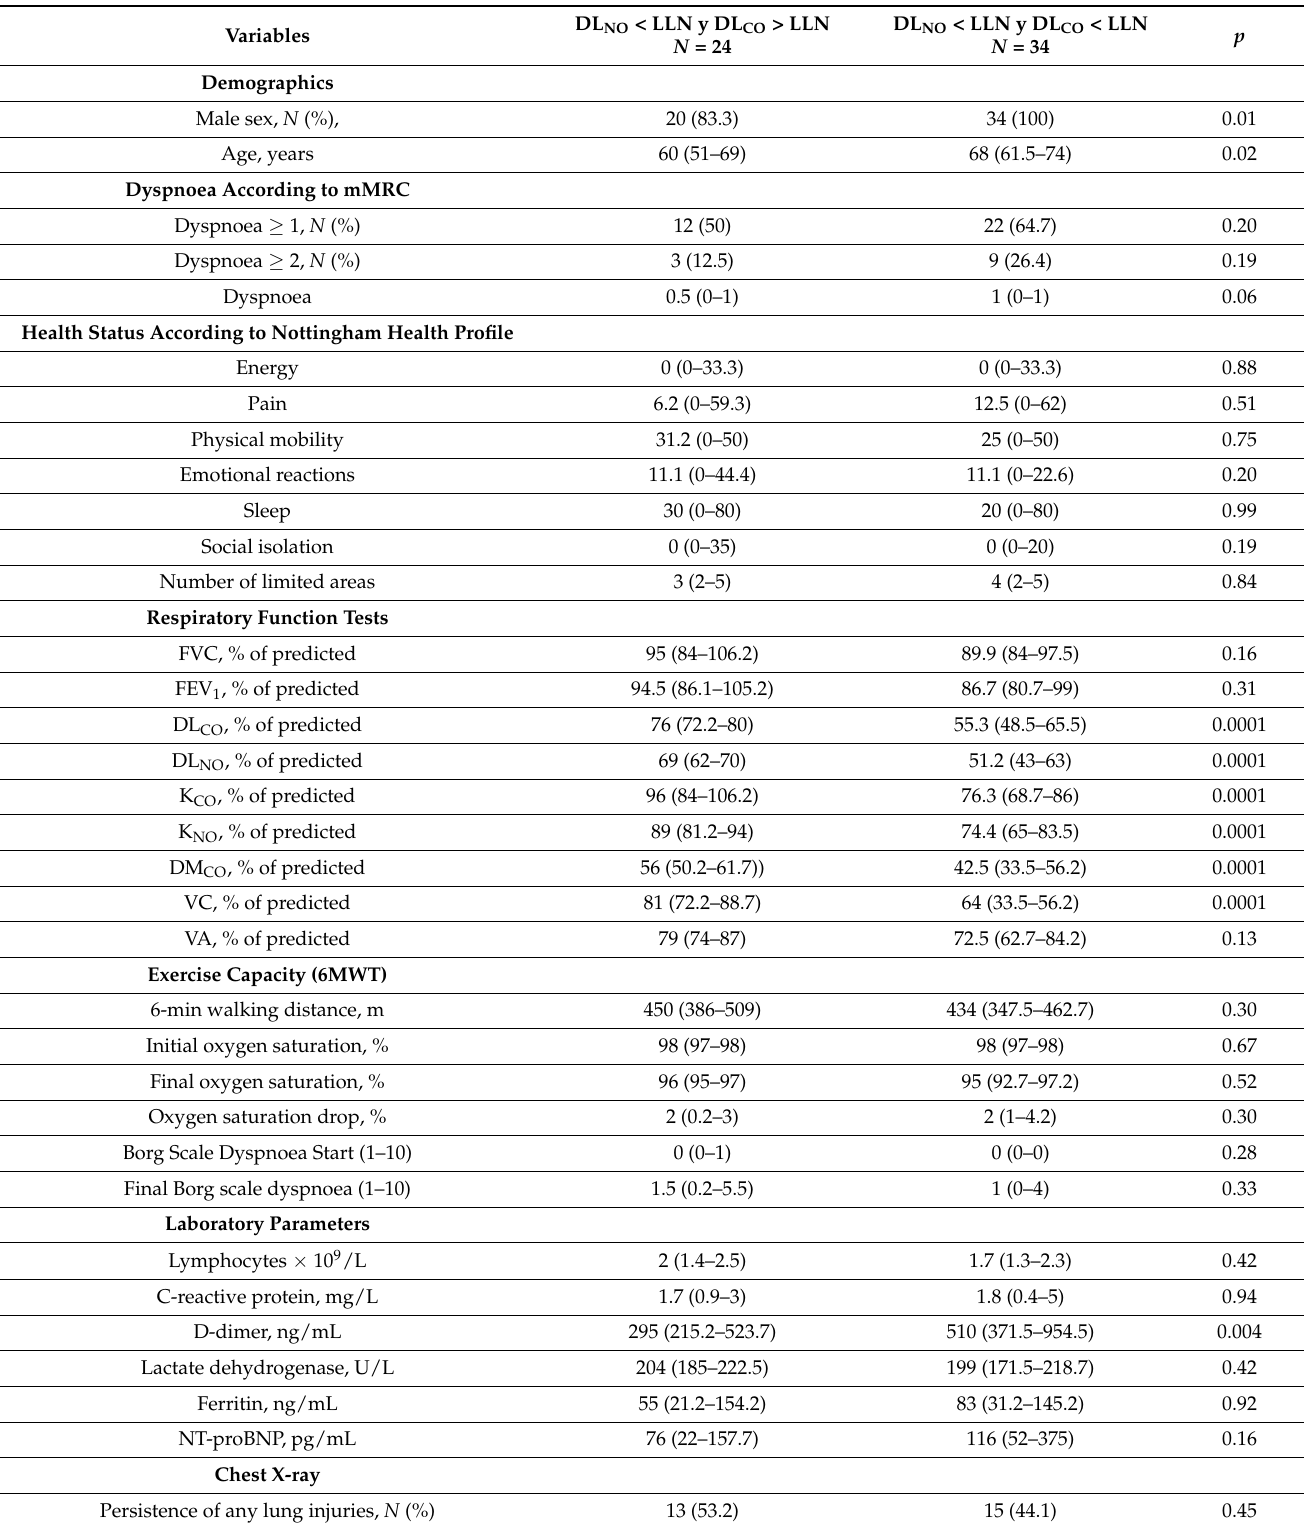
Table 5. Demographic variables, degree of dyspnoea, health status, capacity for physical exertion, analytical determinations, and radiological resolution at 12 weeks, according to the presence or absence of alterations in DL NO , or DL NO and DL